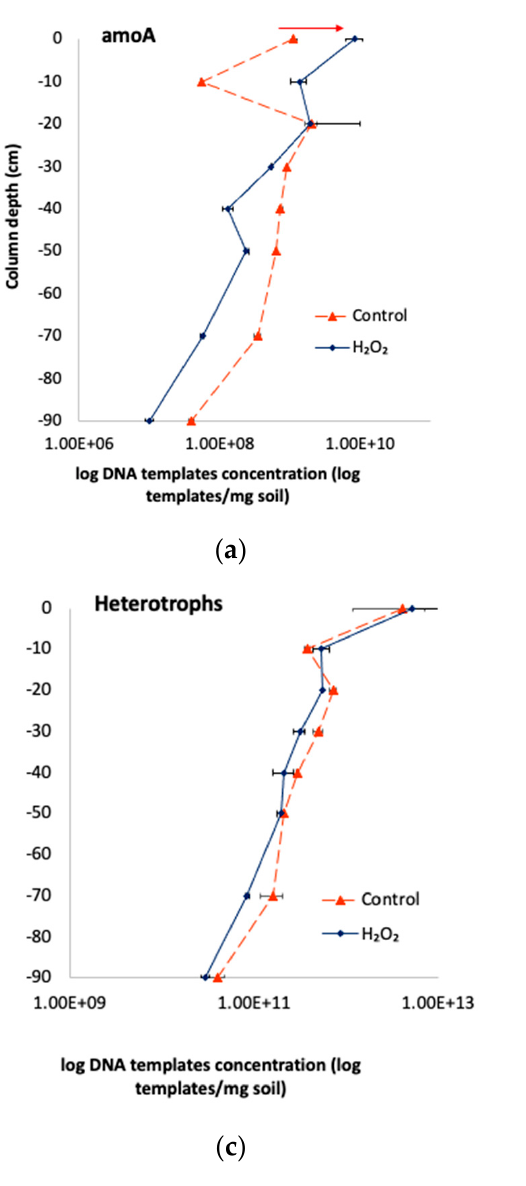
Figure 4. Comparison between control (RC) and peroxide columns (HPC) profiles of the main microbial functional groups along depths. ( a ) Profile concentrations of amoA (AOB); ( b ) NOB (sum of Nitrospira spp. and Nitrobacter spp.); ( c ) total bacteria (universal bacteria, Eub); and ( d ) anammox. Units are in log DNA copy number/mg soil. Columns were fed with synthetic effluent with no H 2 O 2 (top) and 14 mg/L H 2 O 2 (bottom).